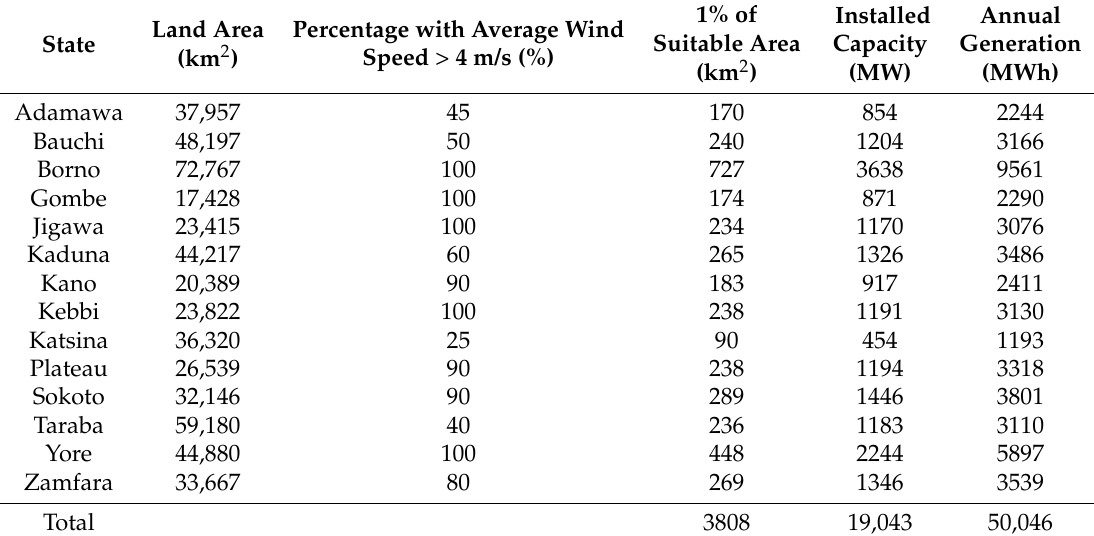
Table 5. Wind energy potential in 14 selected states in Nigeria